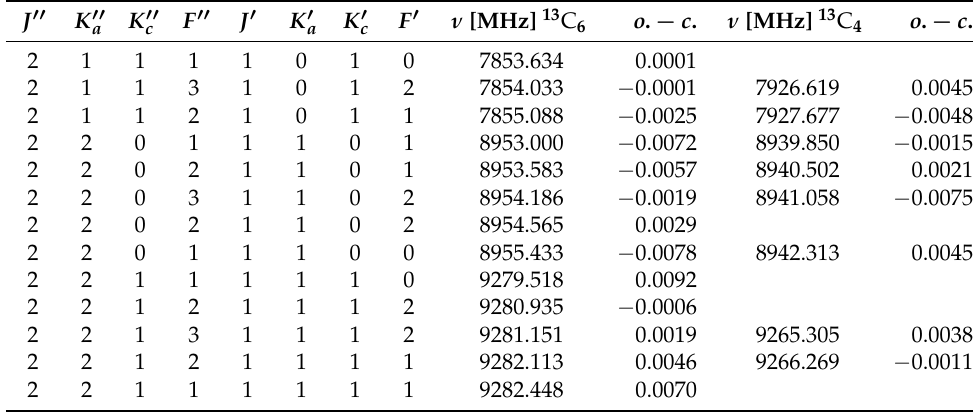
Table A3. Experimental µ b -type transition lines of 13 C-DEHA · H 2